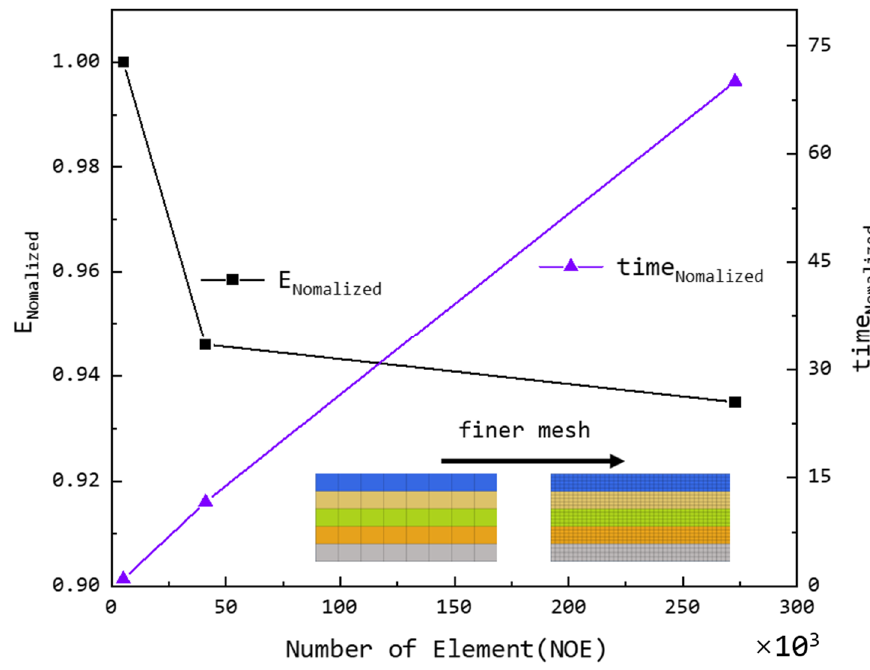
Figure 8. Element number-dependent normalized moduli and computational duration.